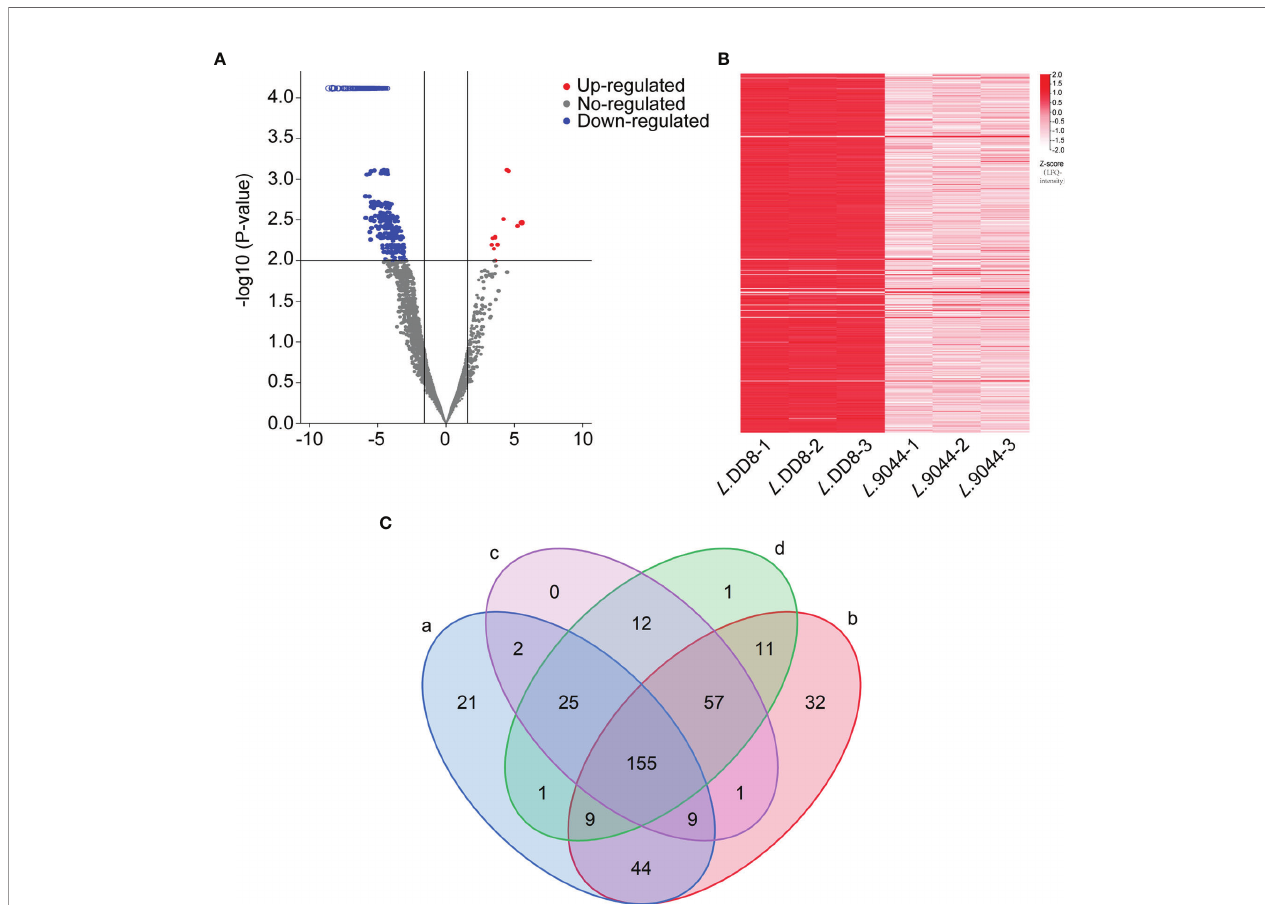
FIGURE 2 | The Differentially expressed proteins analysis between L . DD8 and L . 9044 and the prediction of antigenicity, allergenicity, and human and mouse homologous proteins. (A) Volcanic plot map of differentially expressed proteins of L . 9044 vs L . DD8. (B) Heatmap of differentially expressed proteins of L . 9044 vs L . DD8. (C) a: The number of differentially expressed proteins having antigenic indexes > 0.5 was 266. b: The number of differentially expressed proteins that were not allergenic was 318. c: The number of differentially expressed proteins dissimilar to human proteins was 261. d: The number of differentially expressed proteins dissimilar to mouse proteins was